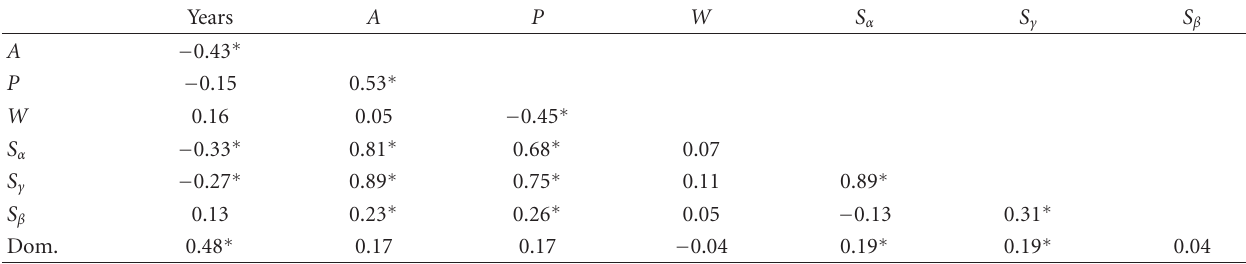
Table 4: Pearson’s correlation analysis of time (years) with annual herbaceous species number ( A ), perennial herbaceous species number ( P ), woody species number ( W ), S α , S γ , S β , and cover of dominant species (Dom.) before treatments in each zone, considering all the study plots ( N = 125 and the three experimental treatments. Marked ( ∗ ) correlations are significant at P < 0 .